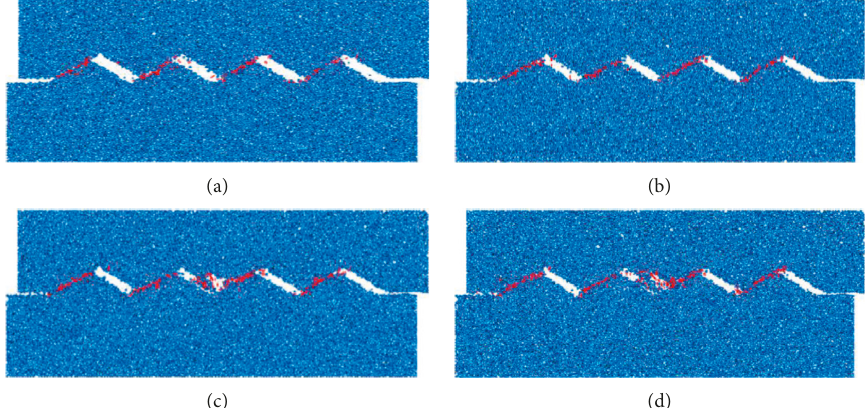
Figure 15: Damage evolution along the sawtooth joint with an inclination angle of 30 ° when the shear displacement is 3mm (red dots indicate the fracture location). Normal stress: (a) 1MPa; (b) 2MPa; (c) 3MPa; (d) 4